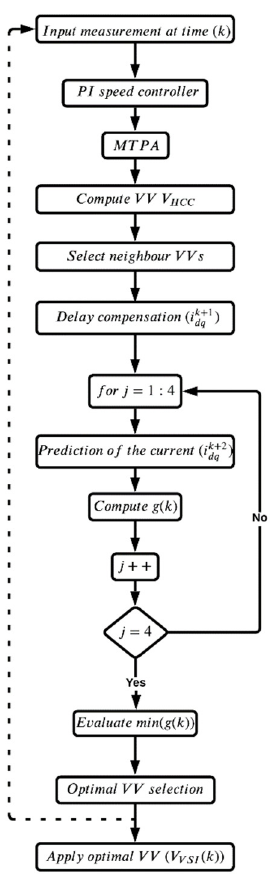
Figure 3. Flowchart of the proposed HCC–MPCC.